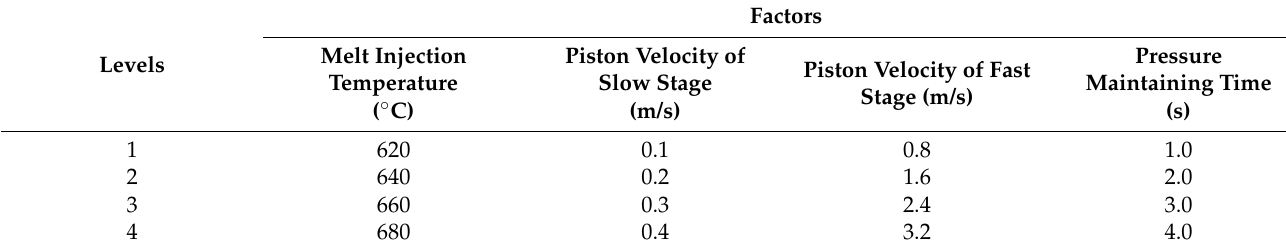
Table 2. Factors and levels of the HPDC orthogonal experiments.